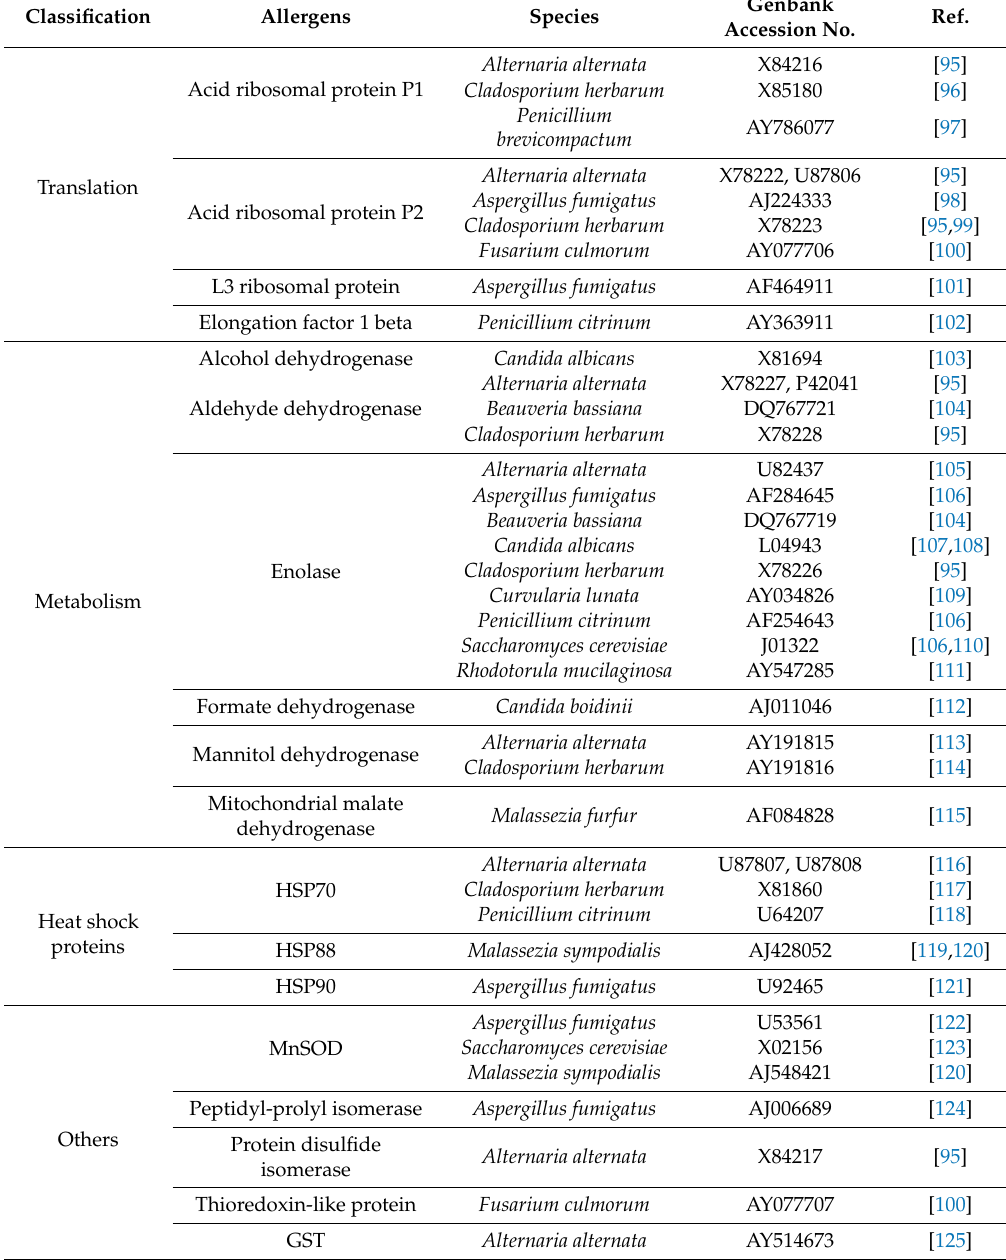
Table 3. Fungal allergens without known secretion signal